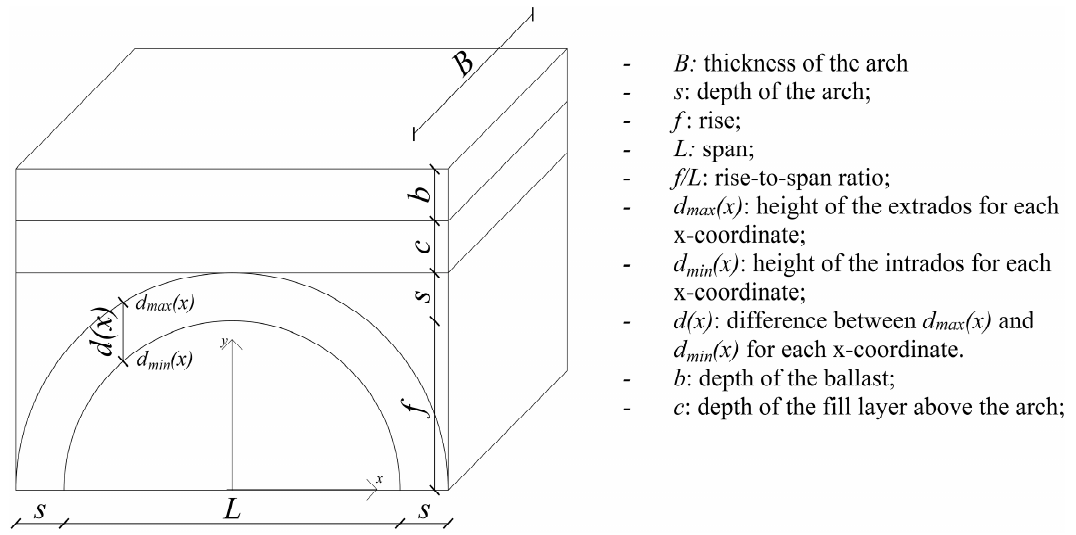
Figure 1. Geometry of a generic arch.